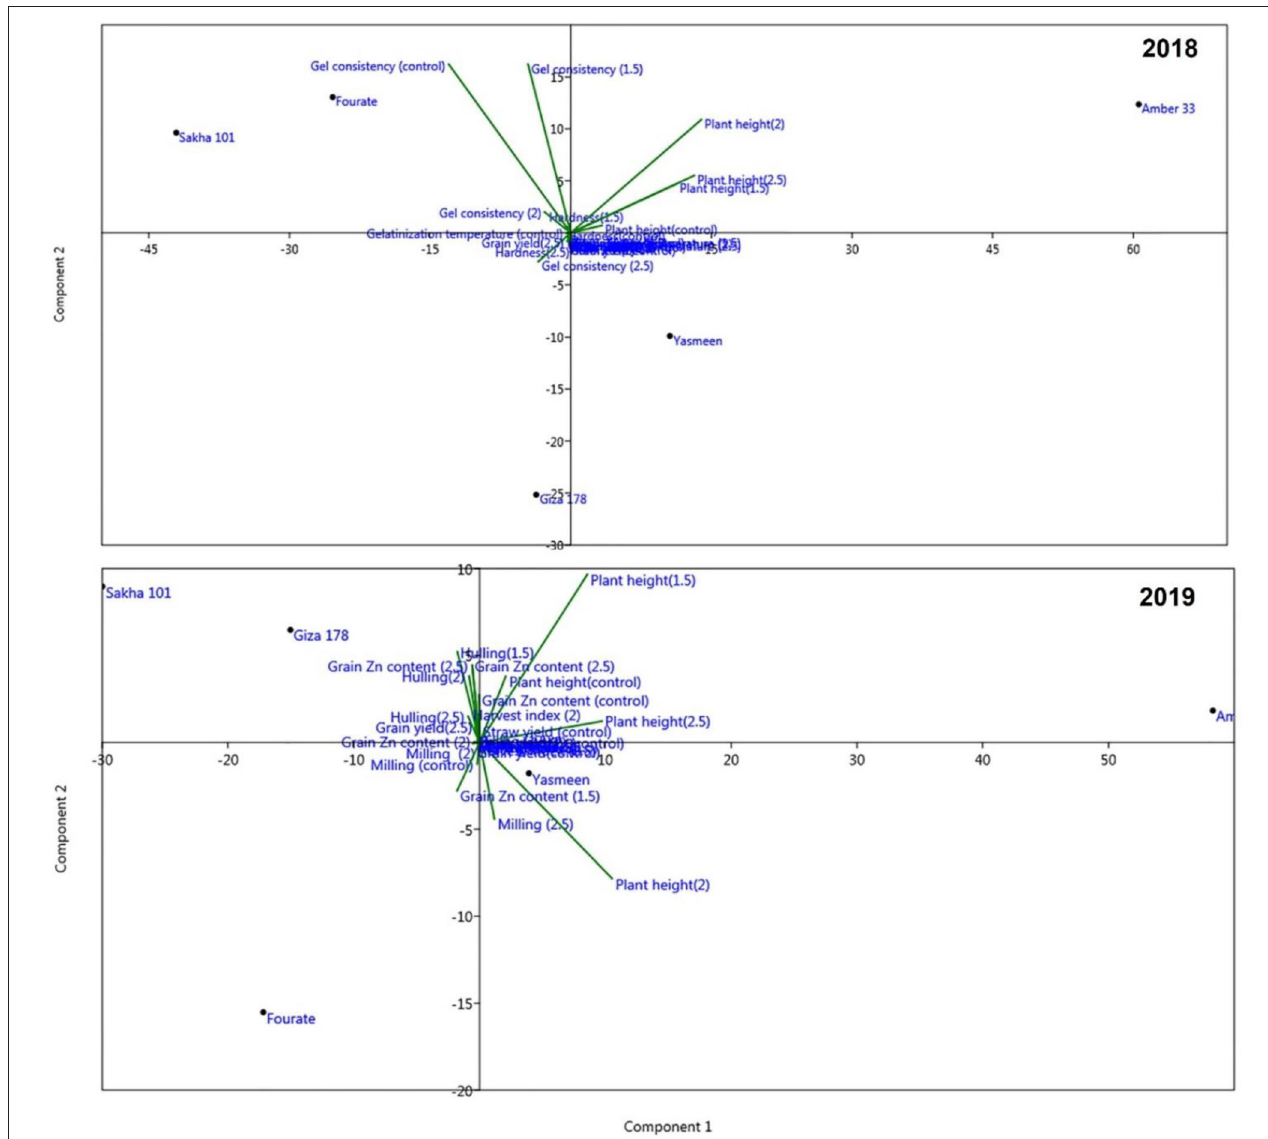
FIGURE 4 | Biplot perceptual mapping shows the genetic similarity distances between five rice genotypes treated with different concentrations of Zn based on physiological and kernel quality attributes in 2018 and 2019 according to Euclidean distance and the unweighted pair group method with arithmetic mean (UPGMA)